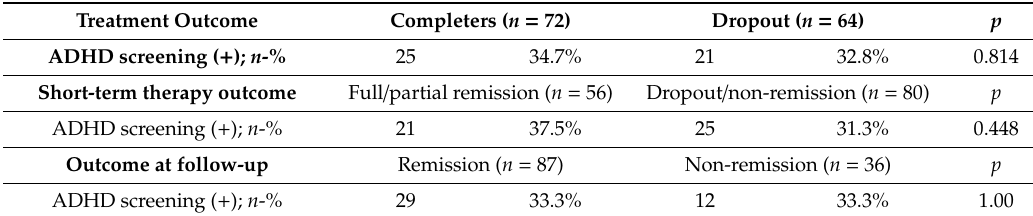
( n = 136) and the follow-up ( n = 123).